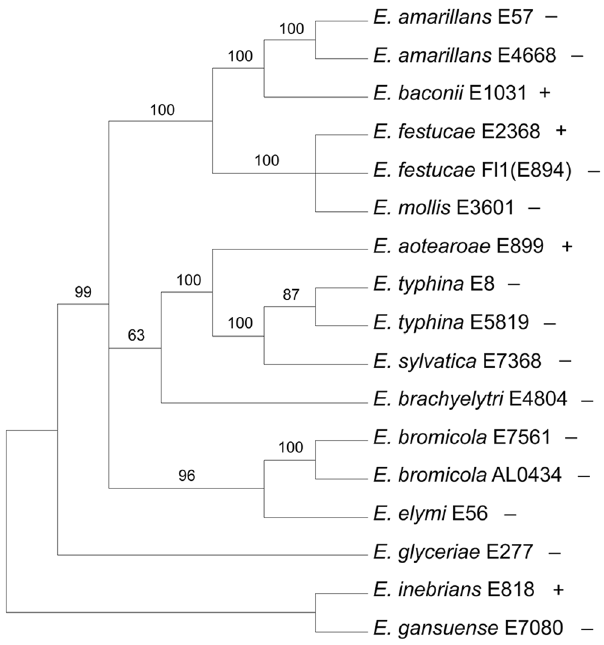
Figure 8. Rooted 50% majority rule maximum parsimony phylogenetic tree of the MCM7 gene DNA sequences (including introns). The E . gansuensis and E . inebrians sequences were designated as the outgroups for rooting the tree. The presence ( + ) or absence ( − ) of an antifungal protein gene in the genome sequence is indicated for each species in the tree. The numbers at the nodes are the bootstrap percentages based on 1,000 replications. The tree was based upon 2,810 total characters, of which 2,492 were constant, 117 variable characters were parsimony uninformative, and 201 variable characters were parsimony informative. Available NCBI accession numbers of the contigs containing the sequences are: E . amarillans E57, AFRF01000144; E . amarillans 4668, JFGZ01000314; E . aoteraoae , JFGX01000075; E . baconii , JFGY01000038; E . brachyelytri , AFRB01001052; E . bromicola ALO4262, LBNH01000152; E . bromicola ALO434, LBNI01000418; E . elymi , AMDJ01000289; E . festucae E2368, ADFL02000041; E . festucae Fl1, AFRX02000143; E . gansuense , AFRE01000016; E . glyceriae , AFRG01000147; E . inebrians , AMDK01000026; E . sylvatica , LCTT01000222; E